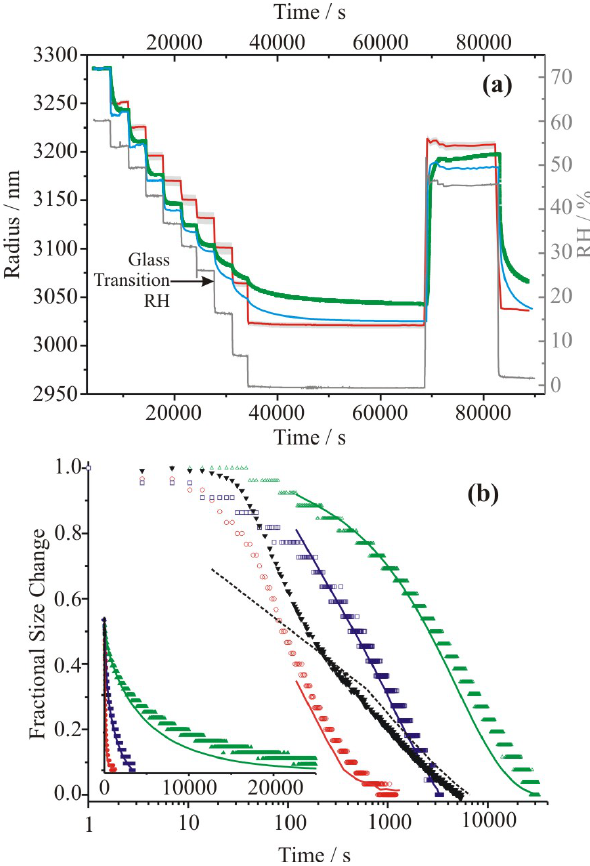
Fig. 5. (a) Time-dependence of the size of a sucrose droplet (green) with change in RH (grey line, right axis). The predicted equilib- rium size using the Norrish (red line) model is shown for compar- ison along with the kinetic model (light blue) which uses the Zo- brist parameterisation for water activity. The grey shaded envelope surrounding the Norrish predictions reports the uncertainty in the model based on the uncertainty in the experimentally determined RH of ± 2%. (b) Comparison of the time-response of droplet size for four of the RH changes reported in part (a) : red, 43 to 36.7%; blue, 26 to 16.3%; green, 6.6 to 0%; black, 45.6 to 1.6%. The experimental data is shown by the symbols and the results of the kinetics simulations by the lines.